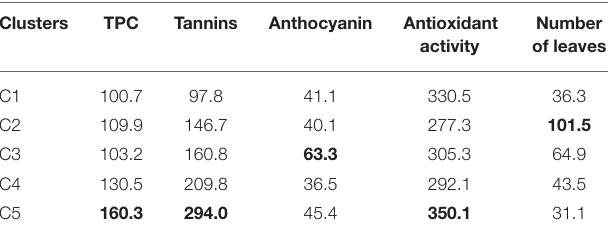
TABLE 4 | Dietary phytochemicals and number of leaves differentiation among spider plant accession clusters. Clusters TPC Tannins Anthocyanin Antioxidant